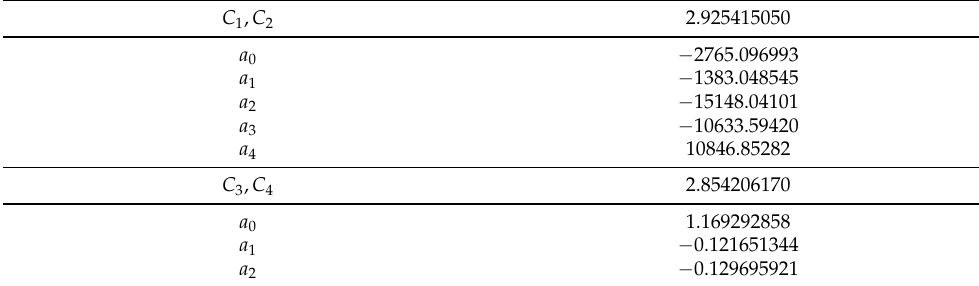
Table 4. Values of C obtained in the second experiment and their corresponding